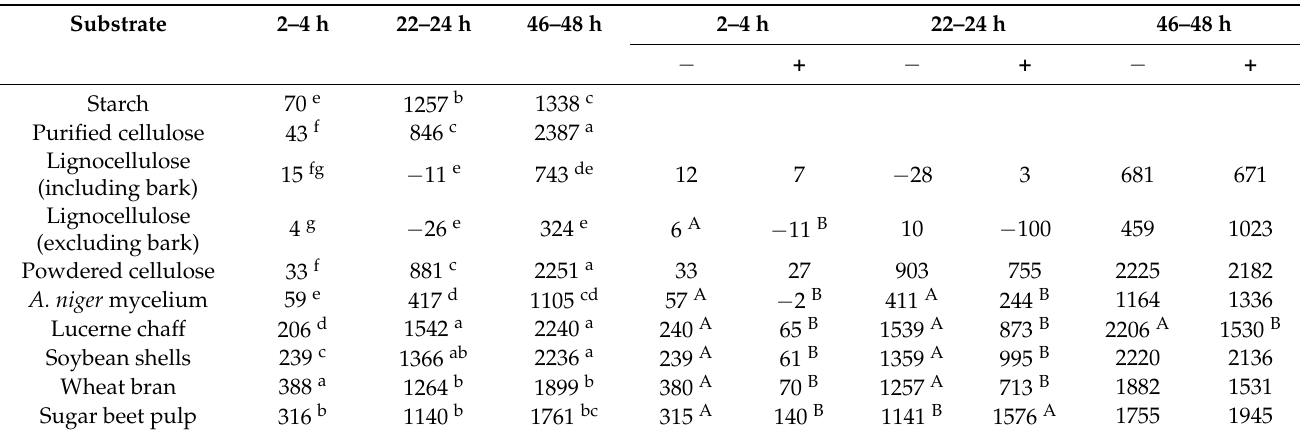
Table 5. Least squares means of CH 4 concentration ( µ mol/L) in fecal inoculum expressed as the difference between CH 4 produced from substrates and CH 4 produced in blanks at three different periods during 48 h of incubation and the effect of enzymatic pre-digestion of the substrates.